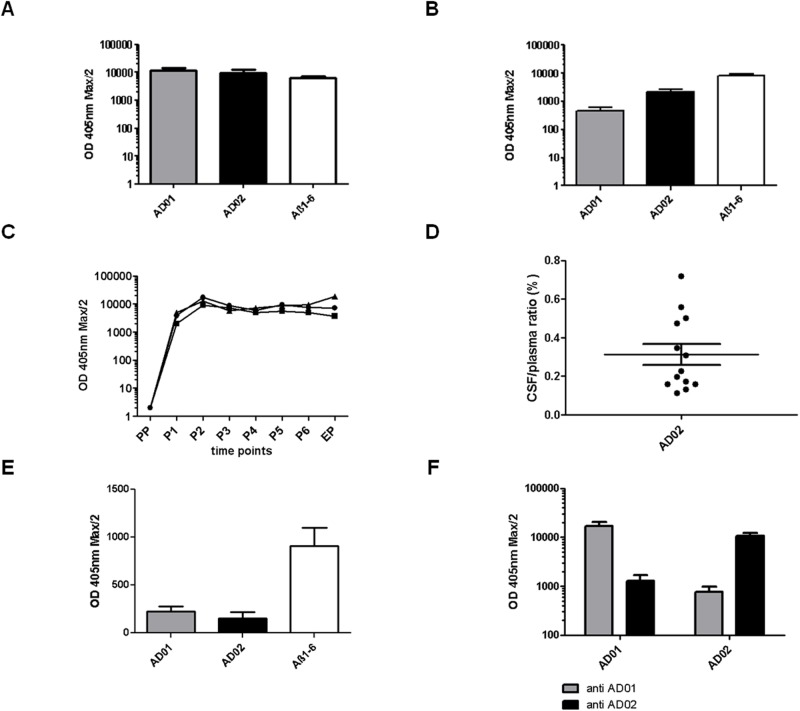
Analysis of the immune response following injection of AD01, AD02 and Aß1-6 conjugate vaccines.Mice were s.c. injected 6 times at a 4-week interval with AD01 (n = 9), AD02 (n = 8) and Aß1-6 conjugate (n = 9) adsorbed to aluminum hydroxide (ALUM). Plasma was taken in monthly intervals and at sacrification. Samples were analyzed for their concentration of IgG Abs against specific peptides. Values depicted are the titer calculated as OD max/2 (at 405nm) plus SEM unless otherwise stated. A) IgG response torwards the respective immunizing peptide (AD01: anti AD01; AD02: anti AD02, Aβ1-6: anti Aβ1-6); B) Reactivity towards human Aβ1-10 after immunization with AD01-, AD02- and Aβ1-6-based conjugate vaccines. Note, none of the 3 vaccines elicits Abs that would react with the Aβ11-19, used as a specificity control (not shown); C) Kinetics of the IgG responses to the immunizing peptide following vaccination with AD01-, AD02- or Aβ1-6 conjugates (AD01… black circle, AD02… black quadrat, Aß1-6… black triangle); D) Ratio of AD02-induced peptide-specific IgG in CSF and plasma. Analysis of AD02-specific IgG levels in CSF and plasma in 13 AD02-immunized animals revealed an average ratio of 0.31% (+/- 0.05%). E) Analysis of sera from vaccinated animals regarding their reactivity towards murine Aβ1-42. Only Aβ1-6 immunized animals show a relevant cross-reactivity to murine Aβ1-42 (Aβ1-6 (n = 9) vs. AD01 (n = 10); p<0.05 and Aβ1-6 (n = 9) vs. AD02 (n = 28); p<0.01); F) IgG response towards the respective immunizing peptide (AD01: anti AD01; AD02: anti AD02) compared to the respective other AFFITOPE peptide (AD01: anti AD02; AD02: anti AD01). Animals included: n = 9 for AD01, n = 8 for AD02.